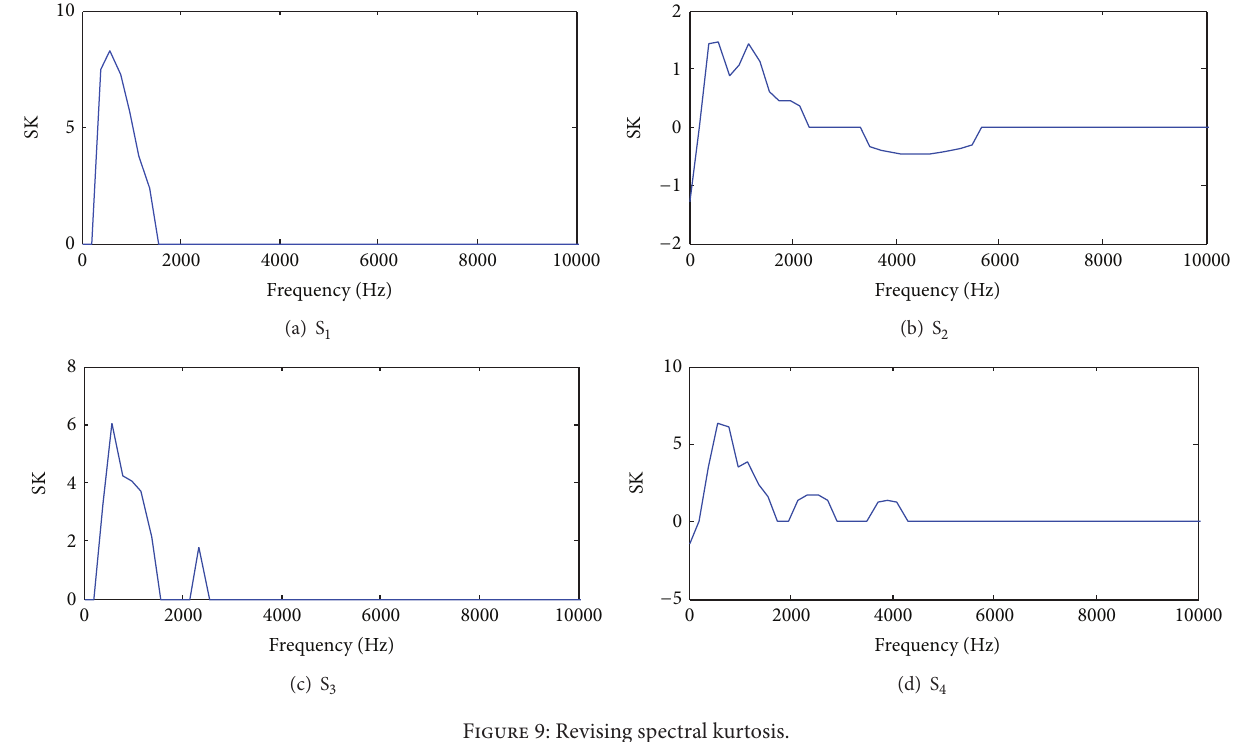
Figure 9: Revising spectral kurtosis.